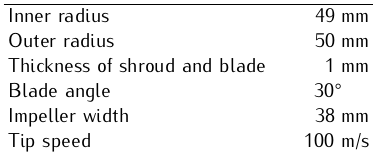
Table 3. Geometry for 3-D FEM model.